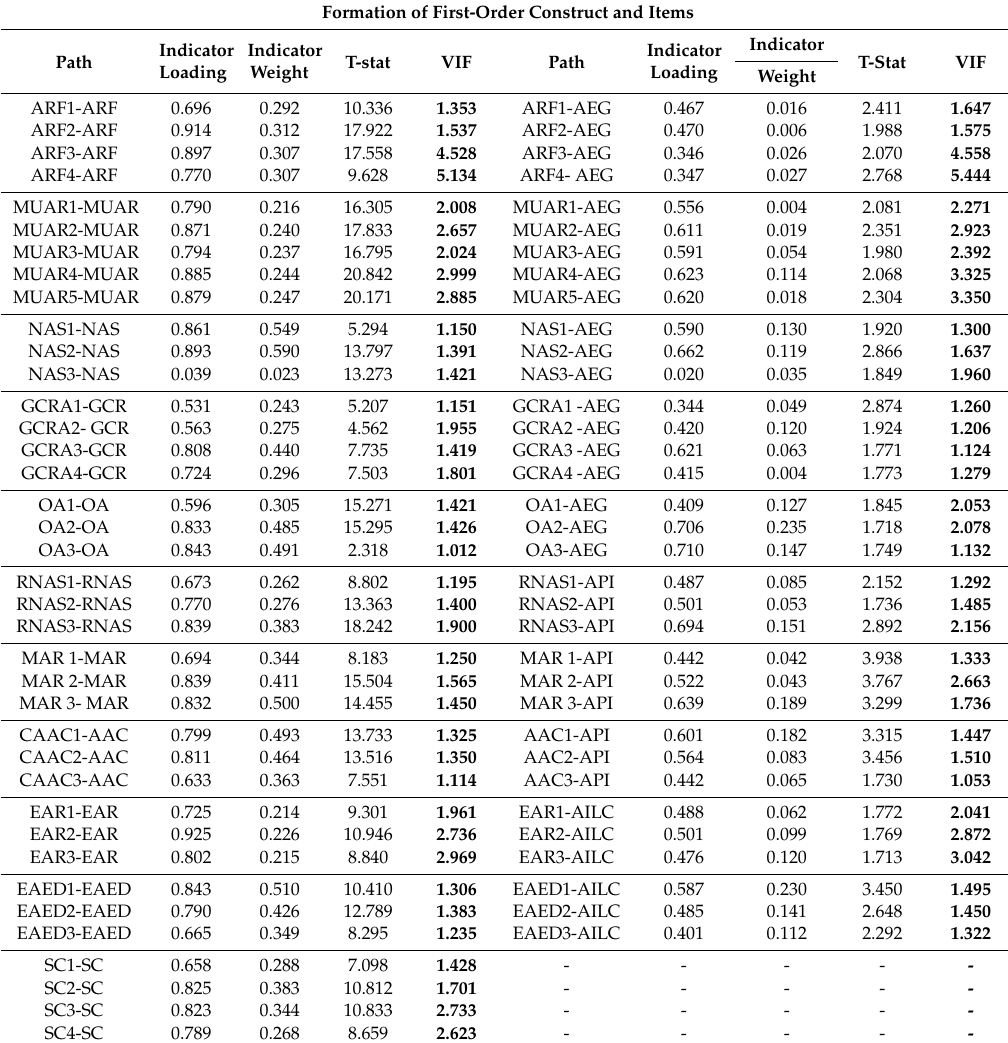
Table 2. Assessment of the measurement